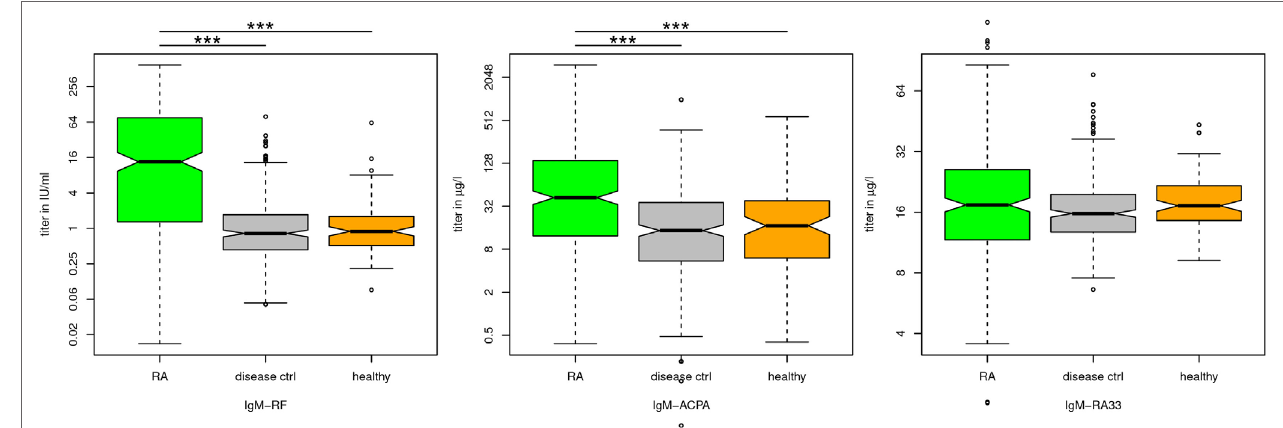
FigUre 1 | Immunoglobulin (Ig) titers of rheumatoid arthritis (RA) patients vs healthy and disease control patients. The significance corresponds fairly to the overlap of the notches in the boxplots: IgM-rheumatoid factor (RF) and IgM-ACPA are significantly ( p ≤ 0.001) different between RA patients and disease controls or healthy subjects, whereas IgM-RA33 titers did not significantly differ between the three